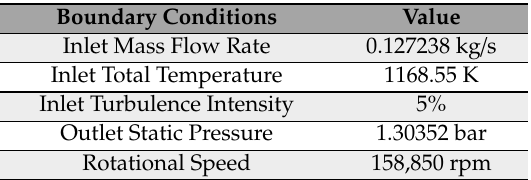
Table 2. Computational fluid dynamics (CFD) boundary conditions at design point